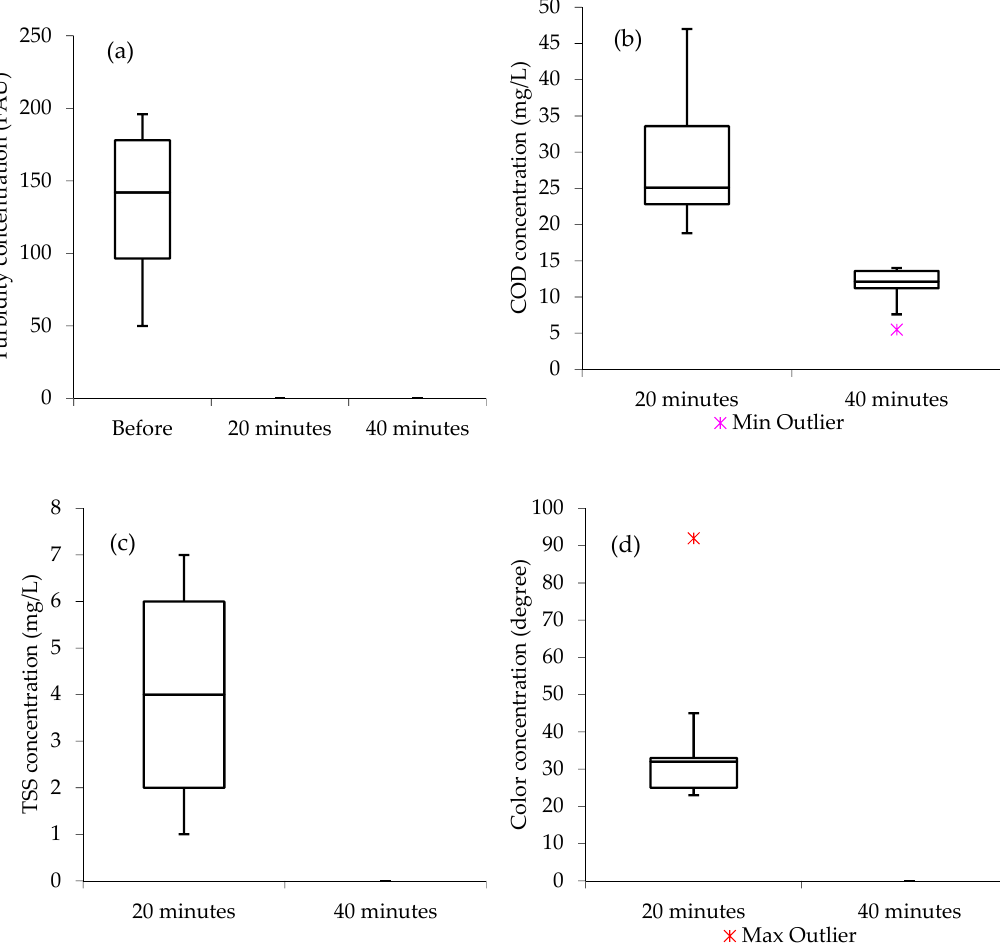
Figure 3. Boxplots (Al–Ti); ( a ) turbidity, ( b ) COD, ( c ) TSS, ( d ) color; Before = before treatment; Min = minimum; Max = maximum.